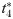
Raw timing curves for all detectors measured during detection of lny64’s t4* using 1.5-ms frames.We extract the trigger events from each curve, from which we obtain the mean—latency—and standard deviation—jitter.